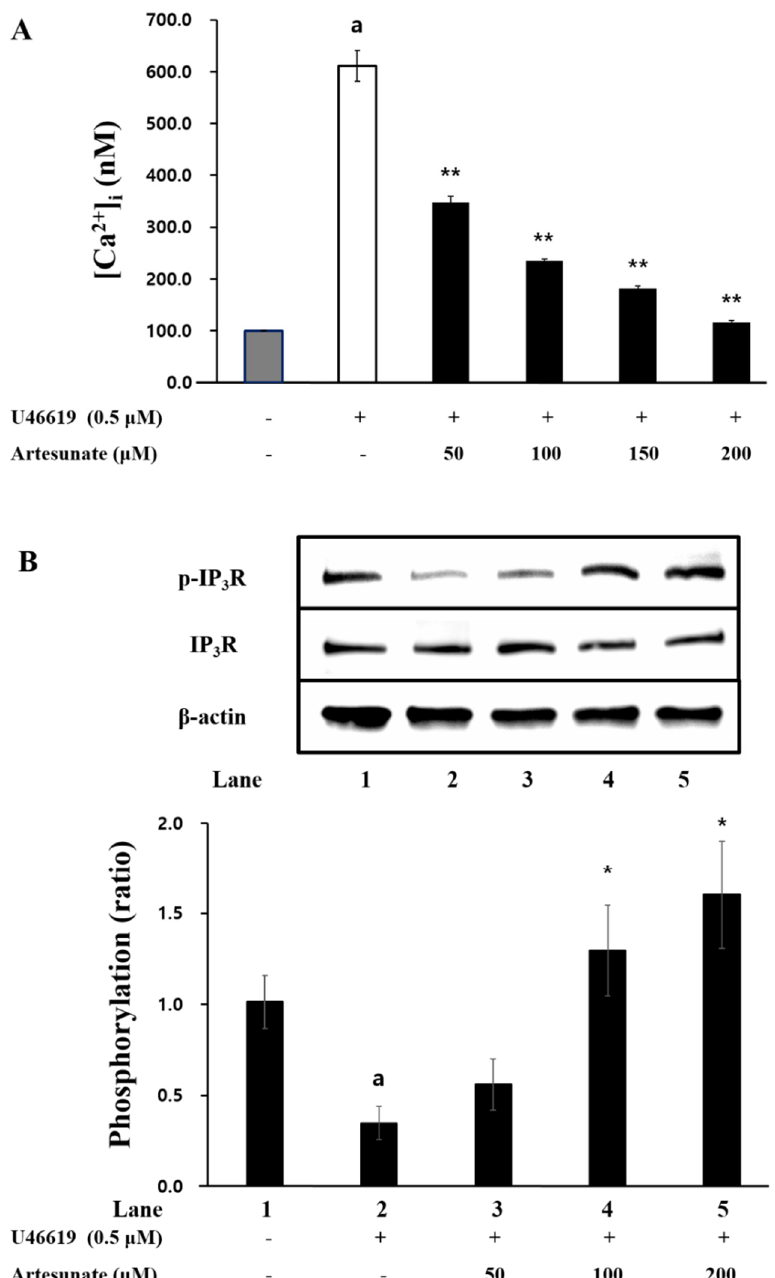
Figure 3. Artesunate’s effect on intracellular Ca 2+ mobilization and IP 3 R phosphorylation. ( A ) Effects of artesunate on intracellular Ca 2+ mobilization. ( B ) Effects of artesunate on IP 3 R phosphorylation. For 60 min, incubation of PRP occurred with Fura 2 − AM (5 µ M) at 37 ◦ C, and the suspending platelets were prepared (10 8 cells/mL) by the steps specified above. The incubation of washed platelets occurred for 3 min at 37 ◦ C with 2 mM CaCl 2 and U46619 (0.5 µ M) stimulation for a duration of 5 min. A spectrofluorometer from BioTeck Instrument measured the Fura 2 fluorescence. The results are shown as mean ± SD ( n = 4). a p < 0.05 in comparison to non − stimulated platelets, * p < 0.05, ** p < 0.001 in comparison to the U46619 − induced platelets.